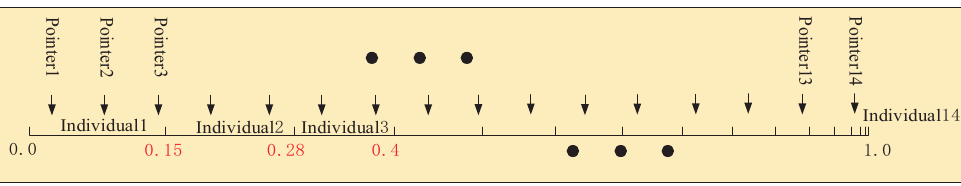
Figure 7. Schematic diagram of SUS principle.The red numbers in the figure are only used to illustrate the principle of this